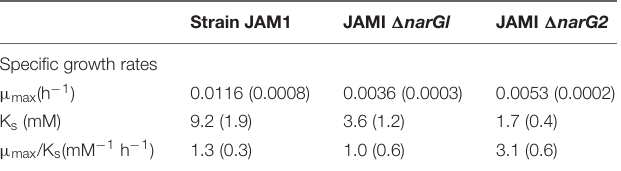
TABLE 3 | Kinetics of growth and nitrate reduction under denitrifying